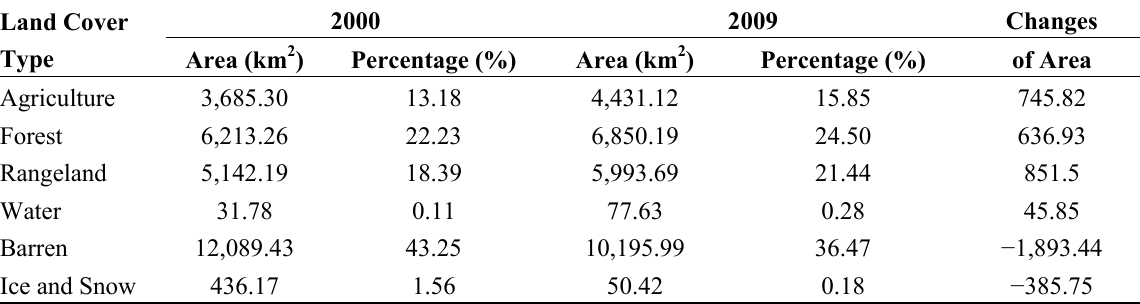
Table 5. 2000 and 2009 classified LULC types, area, percentage, and